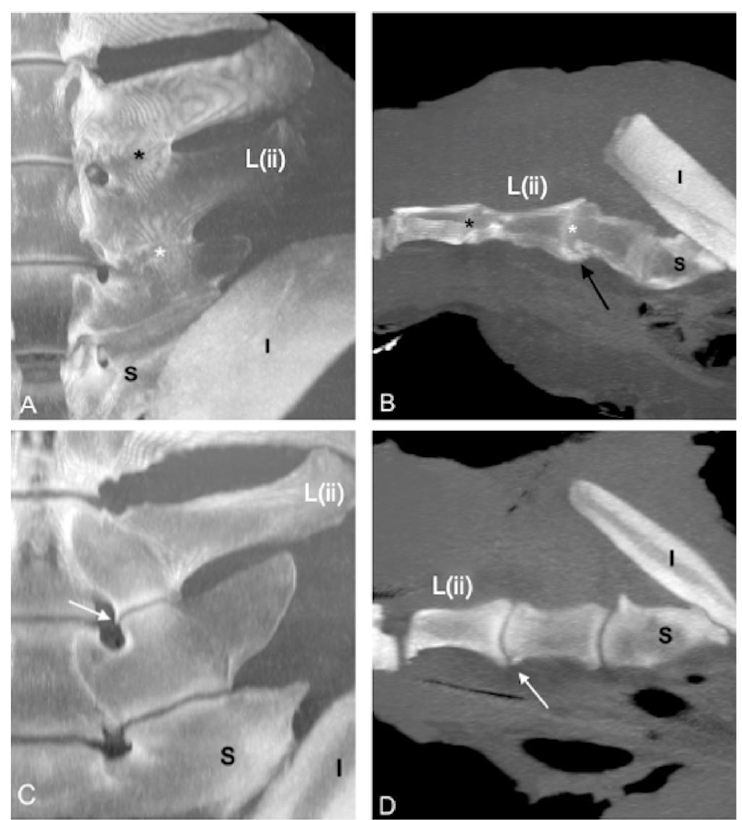
Figure 3. Dorsal (( A , C ); cranial is toward the top) and parasagittal (( B , D ); cranial is toward the left) multiplanar reconstruction computed tomographic images of the lumbosacroiliac specimens 43 and 9, using maximum intensity projection (MIP). ( A , B ) Absence of joint space between the left L(iii)-L(ii) (black asterisk) and L(ii)-L(i) intertransverse joints (ITJs) (white asterisk) and periarticular bone formation onto the ventral margin of L(ii)-L(i) ITJ with complete bridging of the joint (black arrow). ( C , D ) Visible joint space between the left L(ii)-L(i) ITJ with the presence of a small osteophyte involving the ventral periarticular margin of L(i) (white arrow). L: left; R: right; L(ii): second to the most caudal lumbar vertebra; I: ilium; S: